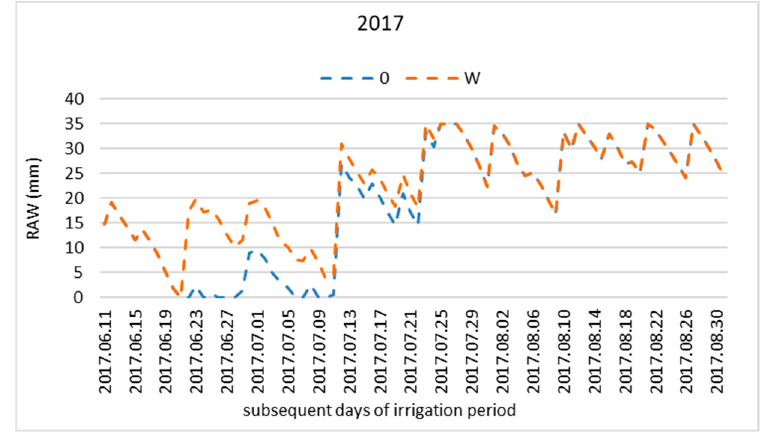
Figure 4. The balance of water readily available to plants in the soil layer with controlled moisture in the period from 11 June to 31 August 2017 (wet season) (0–rainfed, W–irrigation).